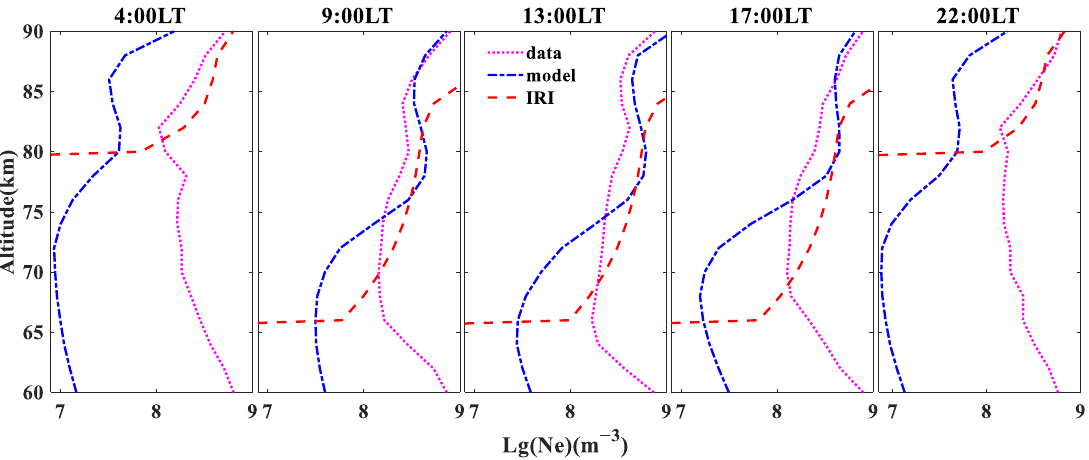
Figure 9. The electron density of the physical model, radar data, and IRI varies with the altitude at 4:00 LT, 9:00 LT, 13:00 LT, 17:00 LT, and 22:00 LT.